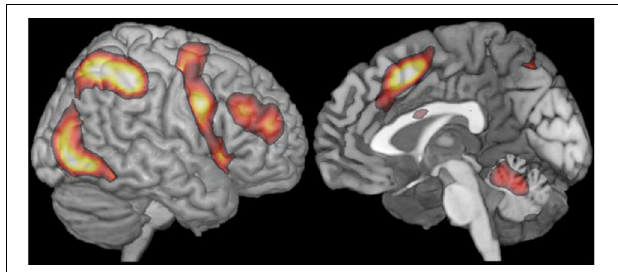
FIGURE 2 | From Fedorenko et al. (2013). A group-level representation of the multiple-demand activity based on average activity in left and right hemispheres. Following reflection of left hemisphere data to the right, 14 (7 tasks × 2 hemispheres) t -maps were averaged, and the resulting map was thresholded at t = 1 . 5. The tasks included: arithmetic addition, spatial working memory, verbal working memory, multi-source interference task (MSIT; Bush and Shin, 2006), a verbal version of MSIT, and Stroop (data from Fedorenko et al.,